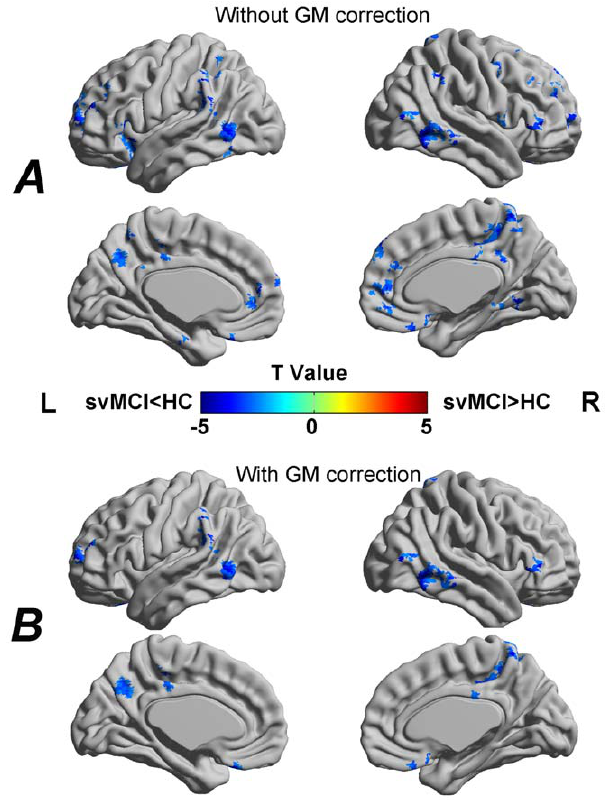
Figure 5. Between-group differences in functional connectivity density without (A) and with (B) correcting GM volume. The svMCI patients showed decreased functional connectivity density in frontal, temporal and parietal regions. Of note, several brain regions which showed functional connectivity density reduction were not significant after GM correction. The statistical threshold was set at P , 0.01 for individual voxels and cluster size . 972 mm 3 , which corresponded to a corrected P , 0.01 determined by Monte Carlo simulations. The t statistical maps were rendered by using the BrainNet Viewer (http://www.nitrc.org/projects/bnv/).R, right; L,